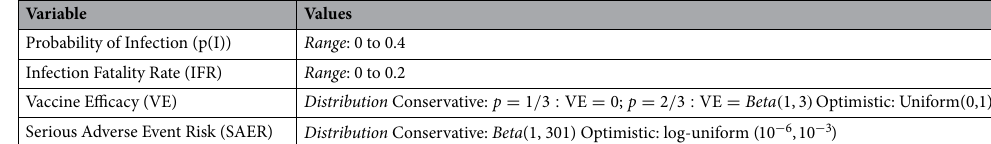
Variable Values Probability of Infection (p(I)) Range : 0 to